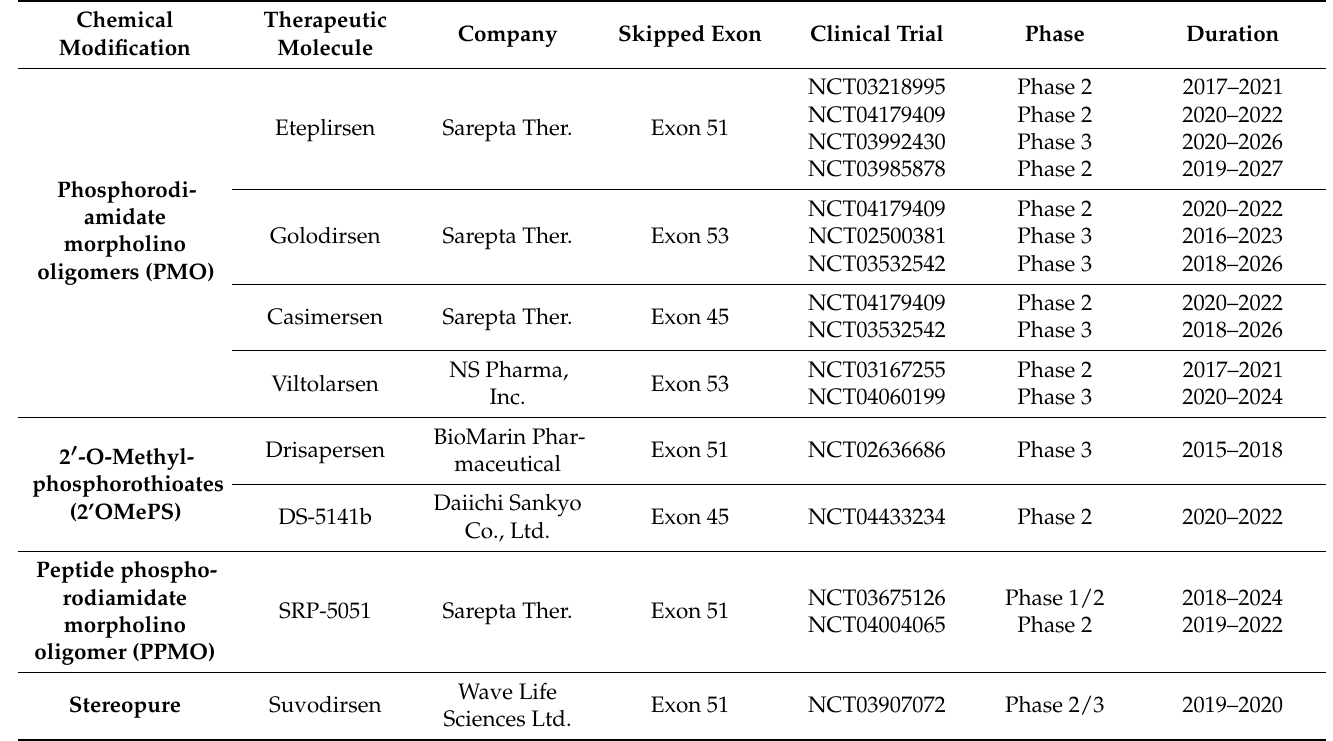
Table 1. Clinical trials (ongoing or recently terminated) evaluating exon skipping induced by AON treatments in DMD patients (http://clinicaltrials.gov (accessed on 15 January